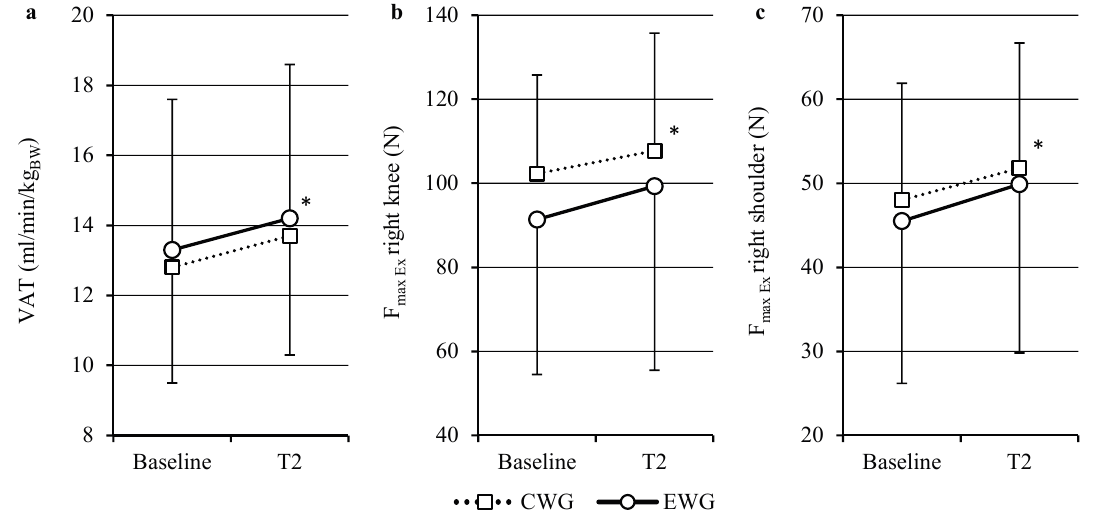
Figure 2. Ventilatory anaerobic threshold ( a ), maximum force for the right knee ( b ) and shoulder extensors ( c ) at baseline and after training (T2). * p < 0.01 over time in both groups with no differences between